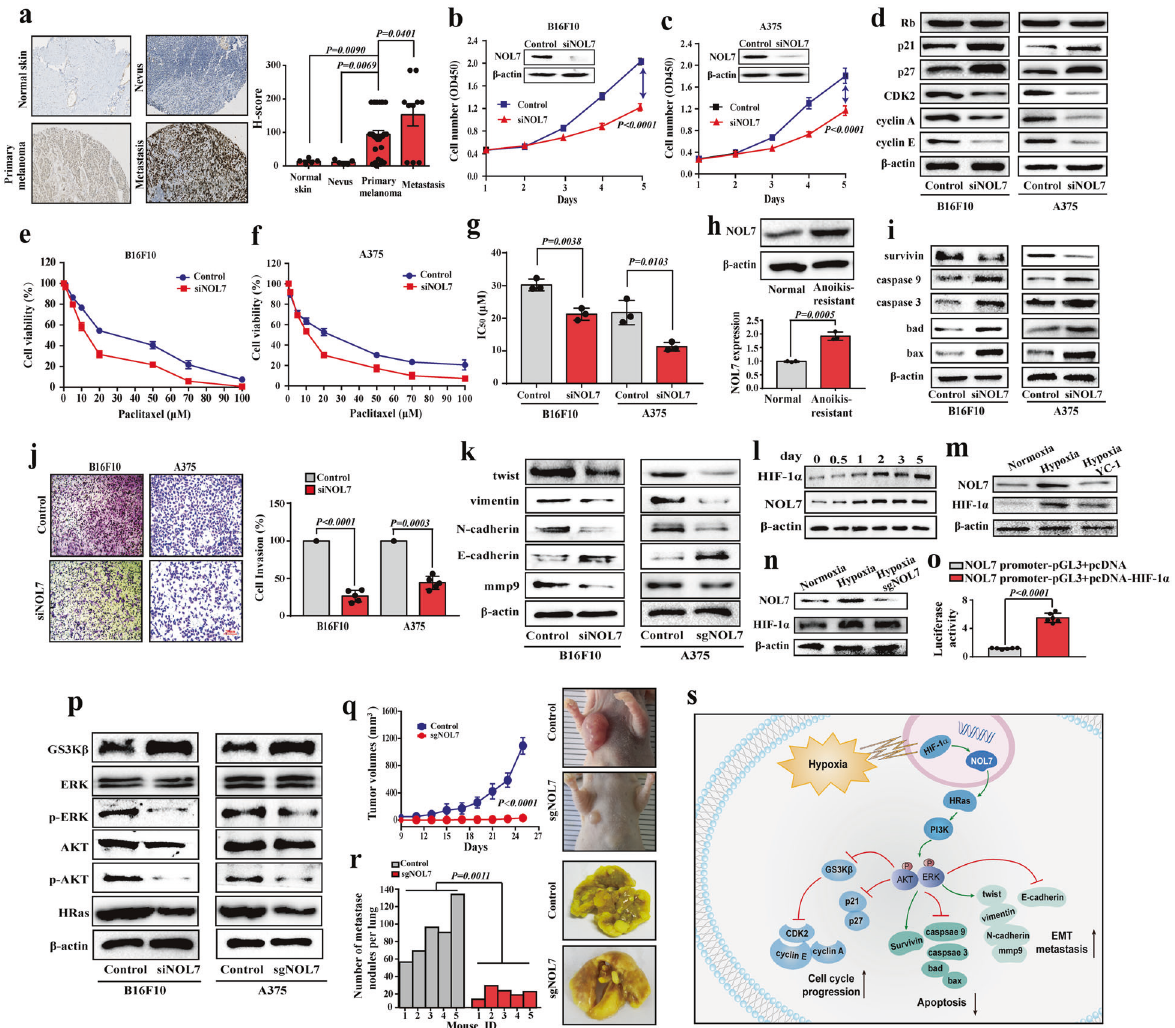
Fig. 1 NOL7 facilitates melanoma progression and metastasis. a NOL7 expression increases in the disease progression from normal skin and nevus to primary melanoma and further to metastatic melanoma as detected by IHC (left panels). The H -score for the quanti fi cation of NOL7 expression is shown on the right panel. b , c Lower cell proliferation upon NOL7 knockdown in B16F10 ( b ) and A375 ( c ) cells. Insets illustrate strongly decreased NOL7 levels upon siRNA targeting of NOL7. d Effect of NOL7 knockdown on cell cycle-associated proteins in B16F10 and A375 cells. NOL7 knockdown decreased the expression level of cyclin A, cyclin E, CDK2, and enhanced the expression level of p21 and p27. See Supplementary Fig. S2g, h for quanti fi cation. e – g NOL7 knockdown increased sensitivity of B16F10 ( e ) and A375 ( f ) cells to paclitaxel. Target cells were incubated with paclitaxel at various concentrations for 24 h and cell viability was tested by the MTT assay. Quanti fi cation of IC 50 values is shown in ( g ). h Western blotting shows the upregulation of NOL7 expression in anoikis-resistant A375 cells as compared to normal A375 cells. Quantitative analysis of NOL7 expression is shown below. i Effect of NOL7 knockdown on apoptosis-related proteins in B16F10 and A375 cells. NOL7 knockdown decreased the expression level of survivin and increased the expression level of caspase 3, caspase 9, bad, and bax. See Supplementary Fig. S5b, c for quanti fi cation. j Phase micrographs showing the invading B16F10 and A375 cells (control and after NOL7 knockdown) at different time intervals. Quantitative analysis of the effect of NOL7 knockdown on cell invasion of B16F10 and A375 cells is shown on the right. k Effect of NOL7 knockdown on EMT-associated proteins in B16F10 and A375 cells. NOL7 depletion increased the expression level of epithelial marker E-cadherin and decreased the expression level of mesenchymal markers, N-cadherin, mmp9, vimentin, and twist in B16F10 and A375 cells. See Supplementary Fig. S6c, d for quanti fi cation. l – n Western blotting shows the concurrent NOL7 and HIF-1 α expression under hypoxia ( l ) plus YC-1 (HIF-1 α inhibitor) ( m ) or upon NOL7 depletion ( n ). See Supplementary Fig. 9b, c for quanti fi cation. o HIF-1 α induces NOL7 expression through promoting the NOL7 transcription, as measured in a dual-luciferase reporter assay following transient transfection with the NOL7 promoter-pGL3 plasmid and pcDNA-HIF-1 α (or the empty pcDNA). The pRL-TK vector was co- transfected to normalize transfection ef fi ciencies. p NOL7 depletion suppressed the PI3K/AKT/ERK signaling pathway through inhibiting the AKT and ERK phosphorylation and activating GSK3 β . See Supplementary Fig. S10a, b for quanti fi cation. q Dramatically reduced tumor growth in nude mice injected with NOL7-knockout cells, compared with that in the control group. Representative images of tumors are shown on the right. r NOL7 knockout strongly decreased the number of lung metastatic nodules. Representative photographs of pulmonary tumor metastases are shown on the right. s Schematic illustration displays the mechanism of NOL7 promoting melanoma tumorigenesis and metastasis. Throughout the fi gure, data are presented as mean ± s.d. ( n ≥ 3); p values are calculated using the t test